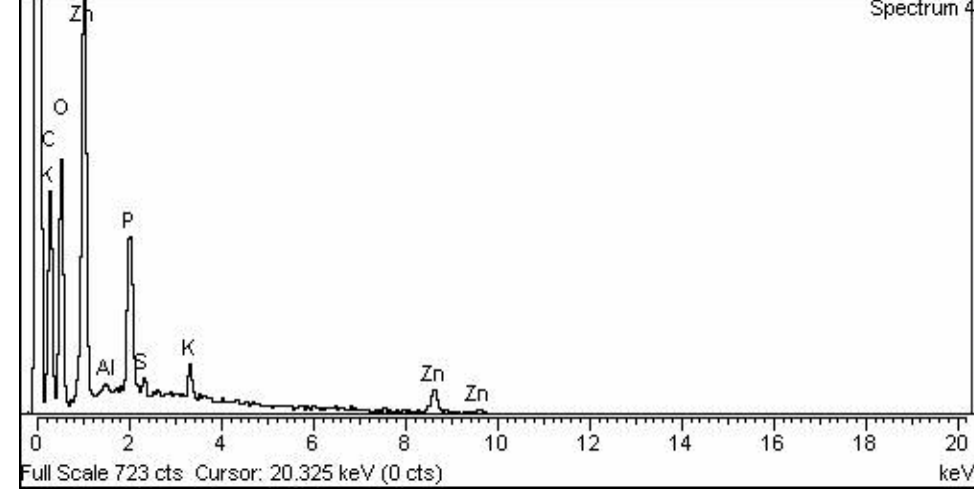
Figure 4. EDX spectrum of the zinc oxide nanoparticles. Table 1. Elemental composition of ZnO nanoparticles after EDX